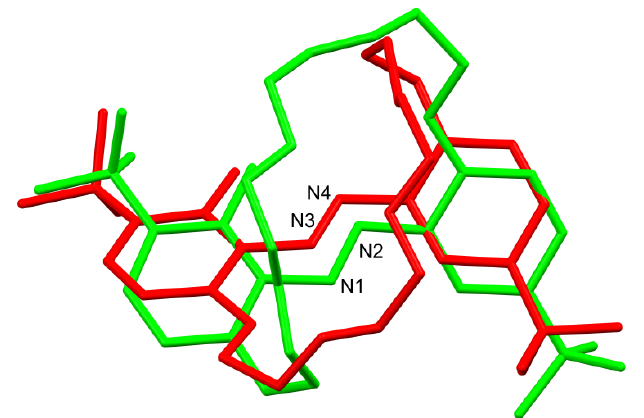
Figure 4. Comparison of the two symmetry-independent molecules of t -Bu-19- o -OH . Note the molecules are not just mutual mirror reflections since the ether linker has significantly different conformation. Colours by symmetry equivalence. The green molecule contains the N1-N2 group, and the red one, containing N3-N4, is inverted, and the best overlap of the molecules is presented (RMSD 1.7196 Å and maximum distance of equivalent atoms 4.023 Å, generated by Mercury 2021.2.0 program). Conformations of ether chains are visibly different.